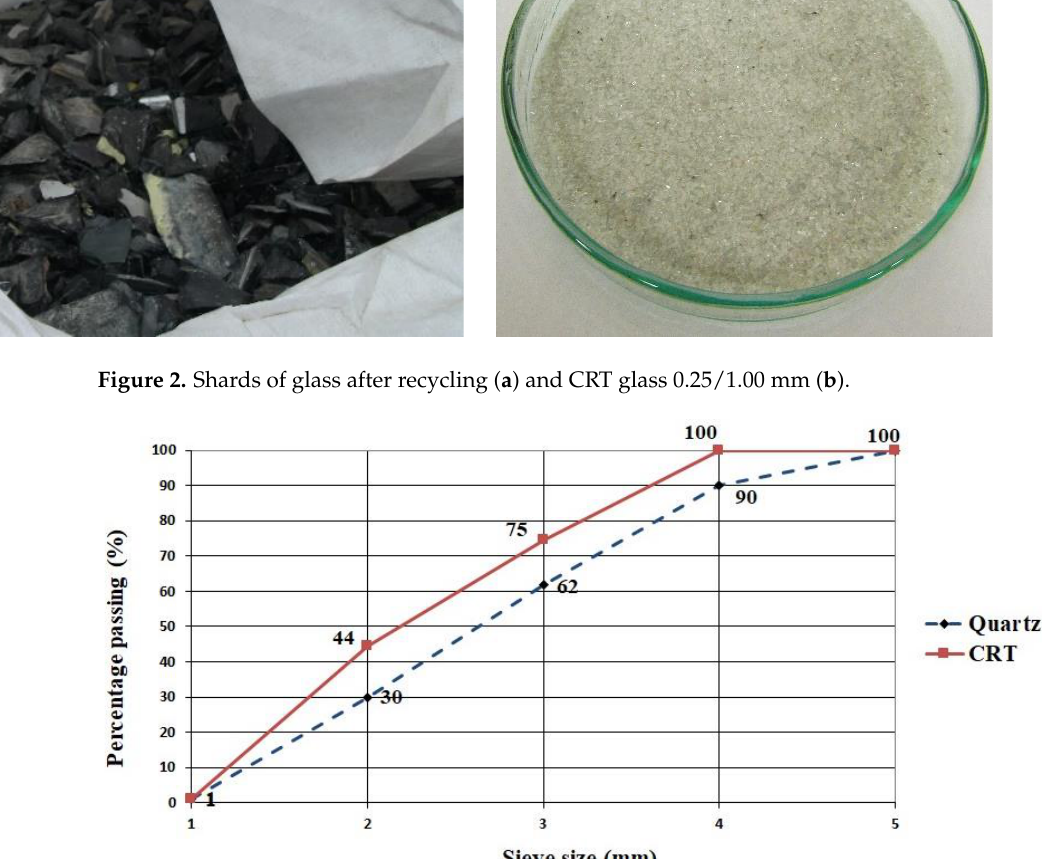
Table 3. Physical properties of fine aggregates and coarse